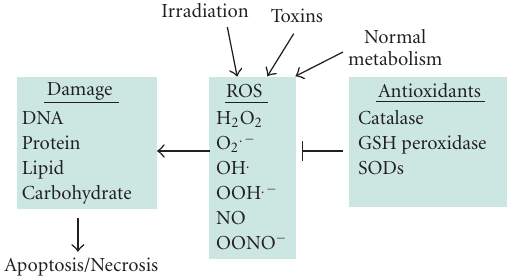
Figure 4: Oxidative stress and cell death. There is a plethora of stimuli that can trigger the generation of reactive oxygen species (ROS), among them irradiation, toxins, and also normal metabolic processes. A range of di ff erent ROS species have been identified, which are kept in check by antioxidant defenses. These include several detoxifying enzymes, for example, catalase, GSH peroxidase, and superoxide dismutase (SOD). If these antioxidants defense mechanisms are too weak, ROS-mediated damage to cellular macromolecules will eventually lead to cell